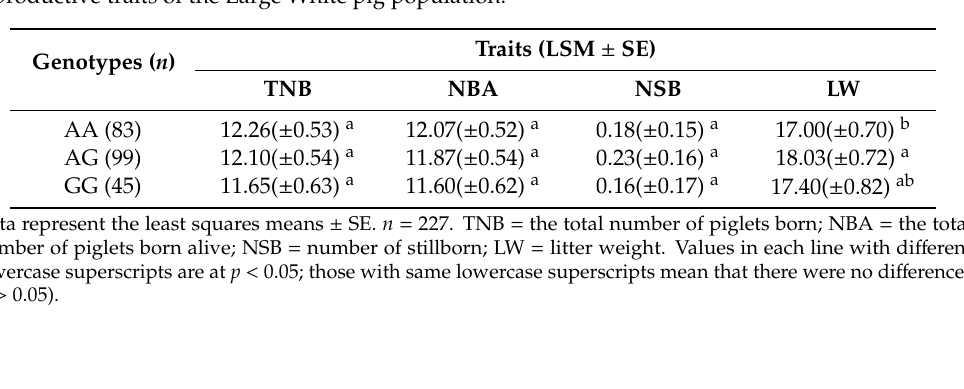
Table 2. E ff ect of the c.1569A > G polymorphism within the 3’-untranslated region of BMP7 on the reproductive traits of the Large White pig